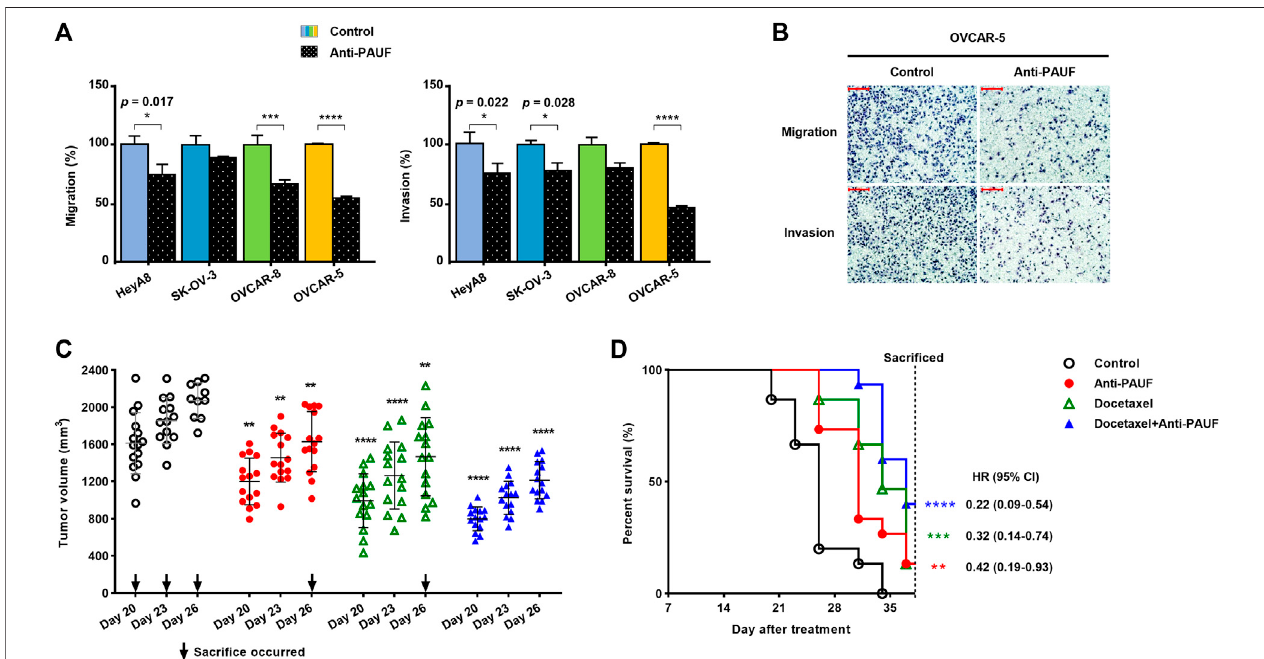
FIGURE3 | Anti-PAUF antibody demonstrated tumor-suppressing effects against ovarian cancers in vitro and in vivo . (A) Effects of anti-PAUF antibody (10 μ g/ml) and human IgG control (10 μ g/ml) treatment on migration and invasion of OVCAR-5 ovarian cancer cells in vitro . (B) Microscopy images (at ×100 magni fi cation) of migration and invasion assay results in OVCAR-5 cells. Scale bar: 100 μ m. (C) Individual tumor volume on day 20, 23, and 26 (the individual curves and mean value of tumor volume from the entire study period can be found in Supplementary Figure S3A and Supplementary Table S1 and (D) survival curves in OVCAR-5 xenograft mouse model, after receiving treatments (started from day 0) of human IgG control, anti-PAUF antibody (10 mg/kg, twice/week, ×4 weeks), docetaxel (10 mg/kg, once, on day 0), or docetaxel + anti-PAUF antibody (via the same regimens of the two drugs). Hazard ratio (HR) is the probability a treated mouse may die during the study period vs. untreated. p p < 0.05, pp p < 0.01, ppp p < 0.001, pppp p <